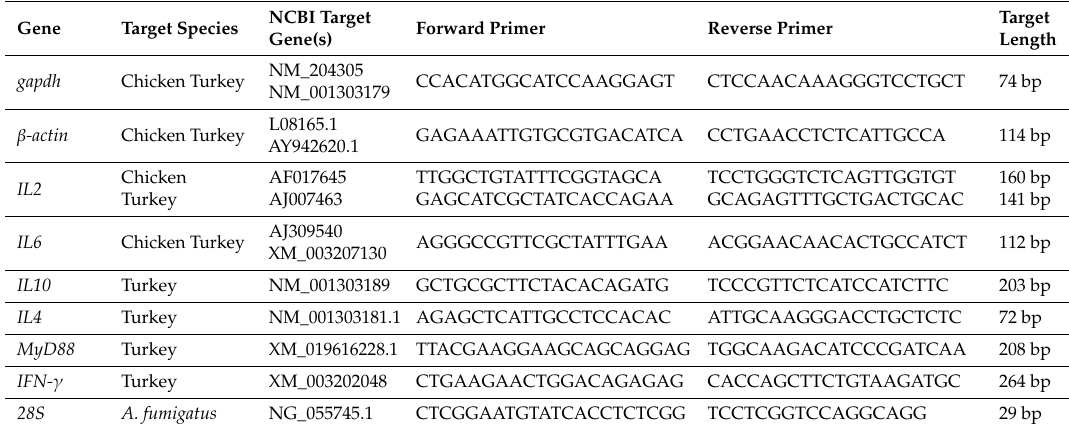
Table 1. Primers used in this